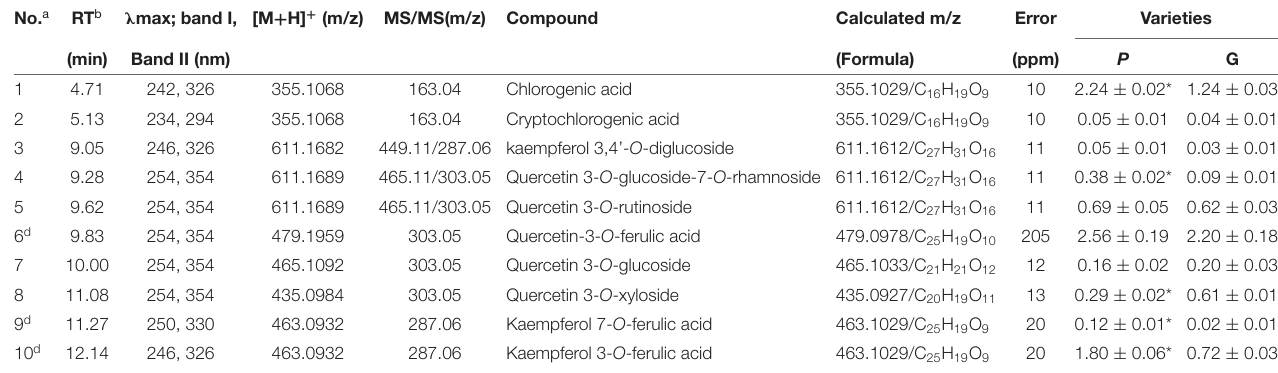
a No corresponds to the chromatographic peaks shown in Supplementary Figure S1 . b RT, retention time. c Nd, not detected. G, Florence. P, Bronze. d Compounds identified in fennel for the first time. * Represents significance (p <